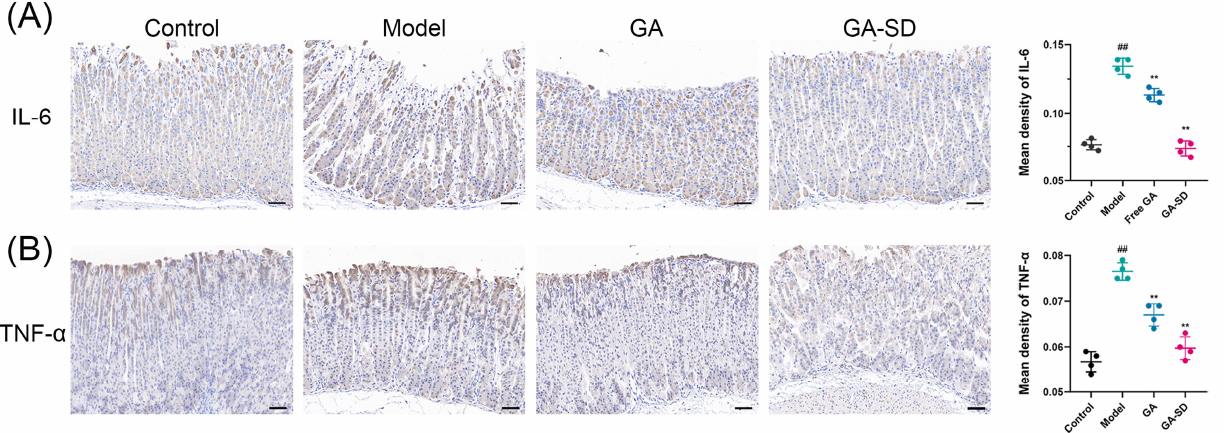
Figure 12. Immunohistochemical analysis of IL-6 and TNF-α in gastric tissues (magnification of 20×). Scale bar: 50 µm. ( A ) Representative photomicrographs of immunohistochemical staining for IL-6 among different groups. ( B ) Representative photomicrographs of immunohistochemical staining for TNF-α among different groups. Data are presented as the mean ± SD ( n = 4) ## p < 0.01 vs. control. ** p < 0.01 vs. the model group.